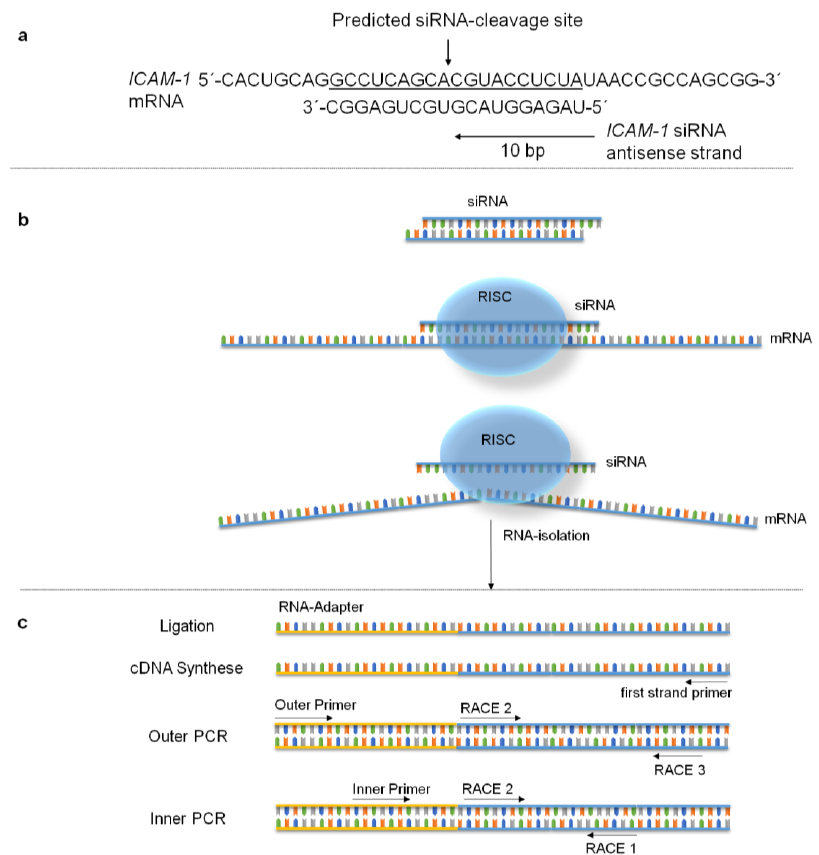
Figure 9. Illustration of the RNA Interference mechanism and the 5´-RLM-RACE PCR technique. ( a )